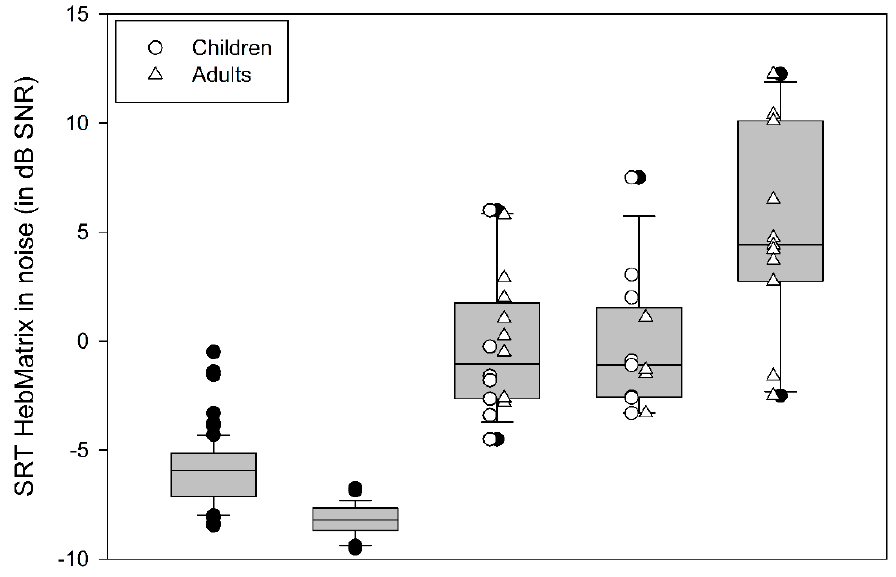
Figure 2. Box-and-whisker plot of the SRTn of the Hebrew Matrix sentence-in-noise test (mean SNR in measurements 3, 4) for early-implanted CI users ( n = 16), progressive CI users ( n = 13), late-implanted CI users ( n = 11), and NH controls (children: n = 80, adults: 56). Also shown are the individual results of the children (empty circles) and adult (empty triangles) CI users. Note that within the “early-implanted” CI group, the children were implanted before two years of age.